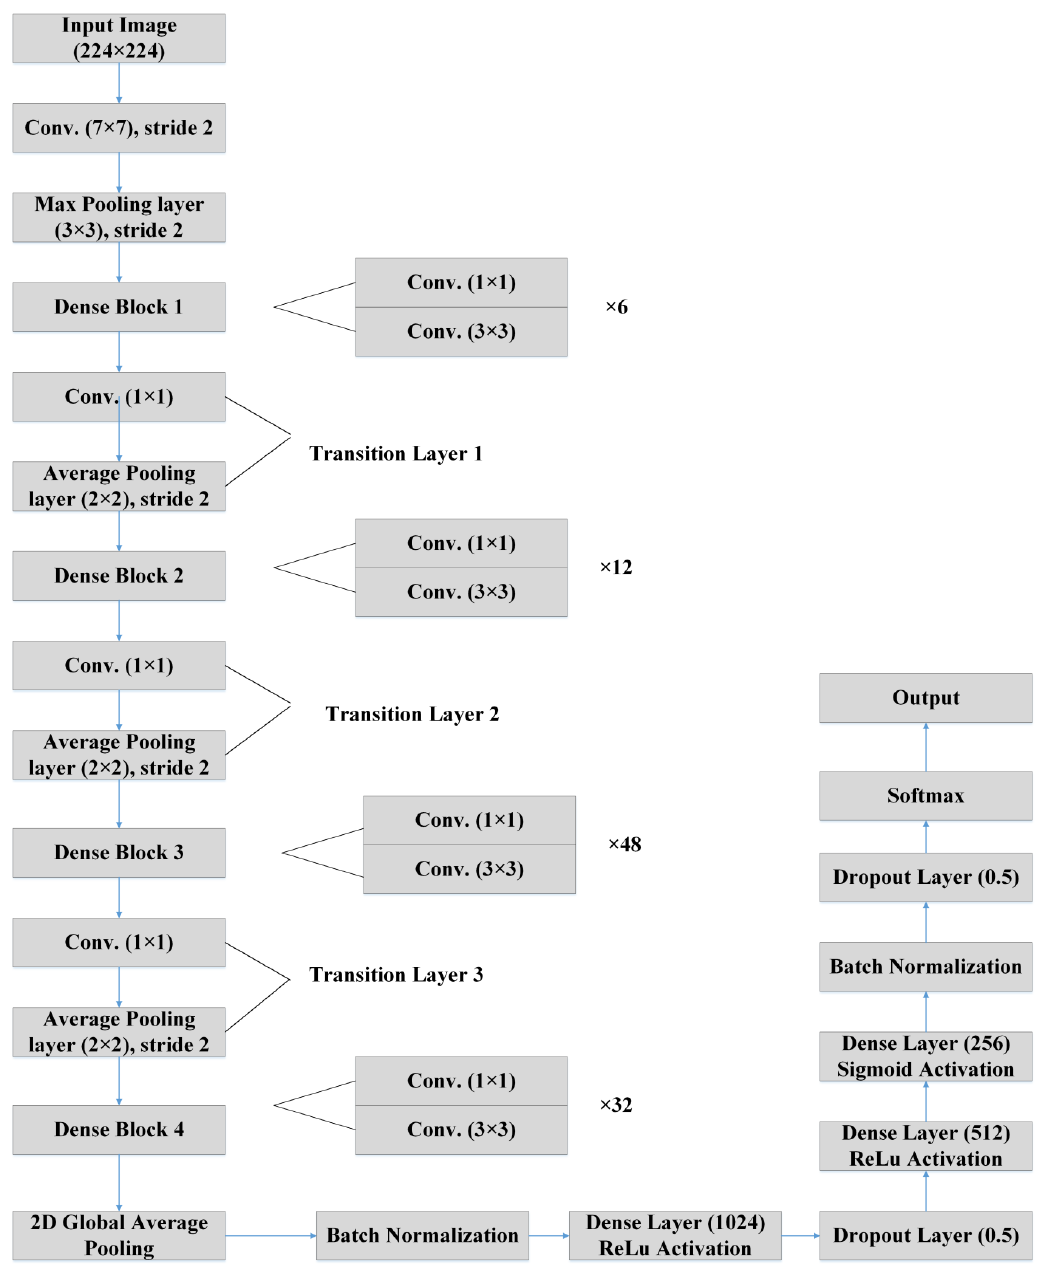
Figure 5. LDDNet architecture [57].